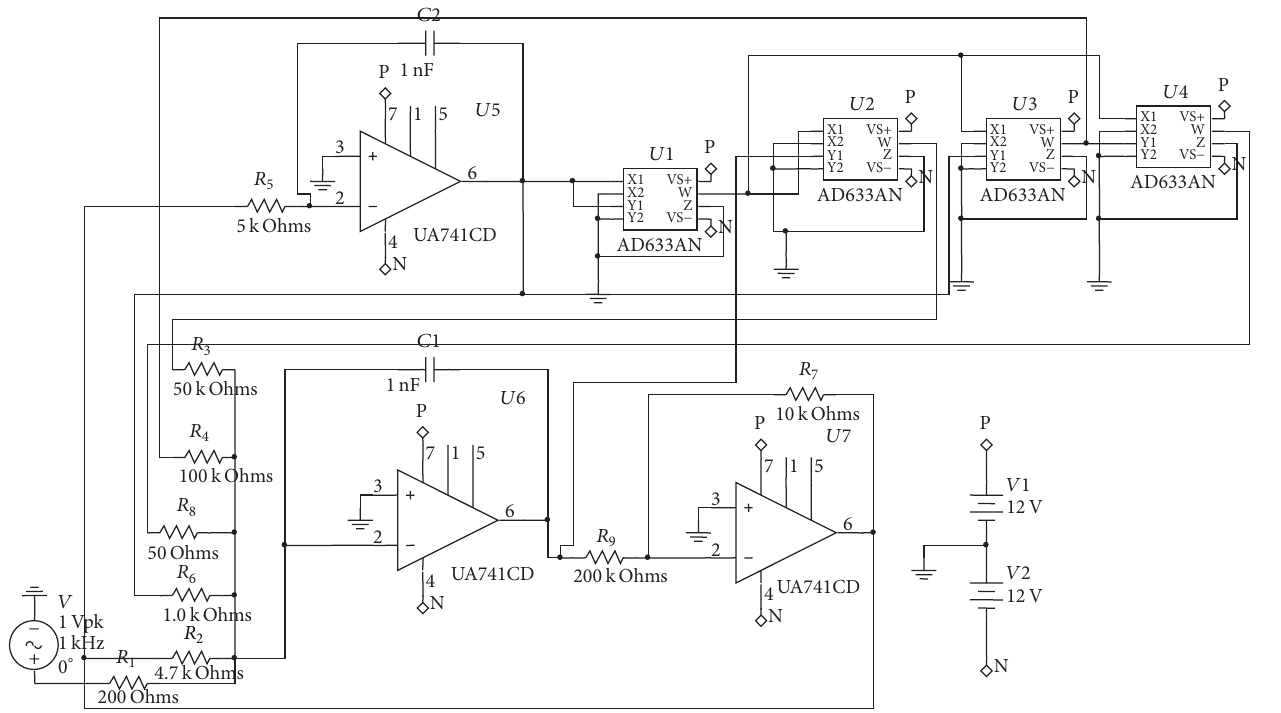
Figure 4: Analog circuit of 𝜙 6 -Van der Pol